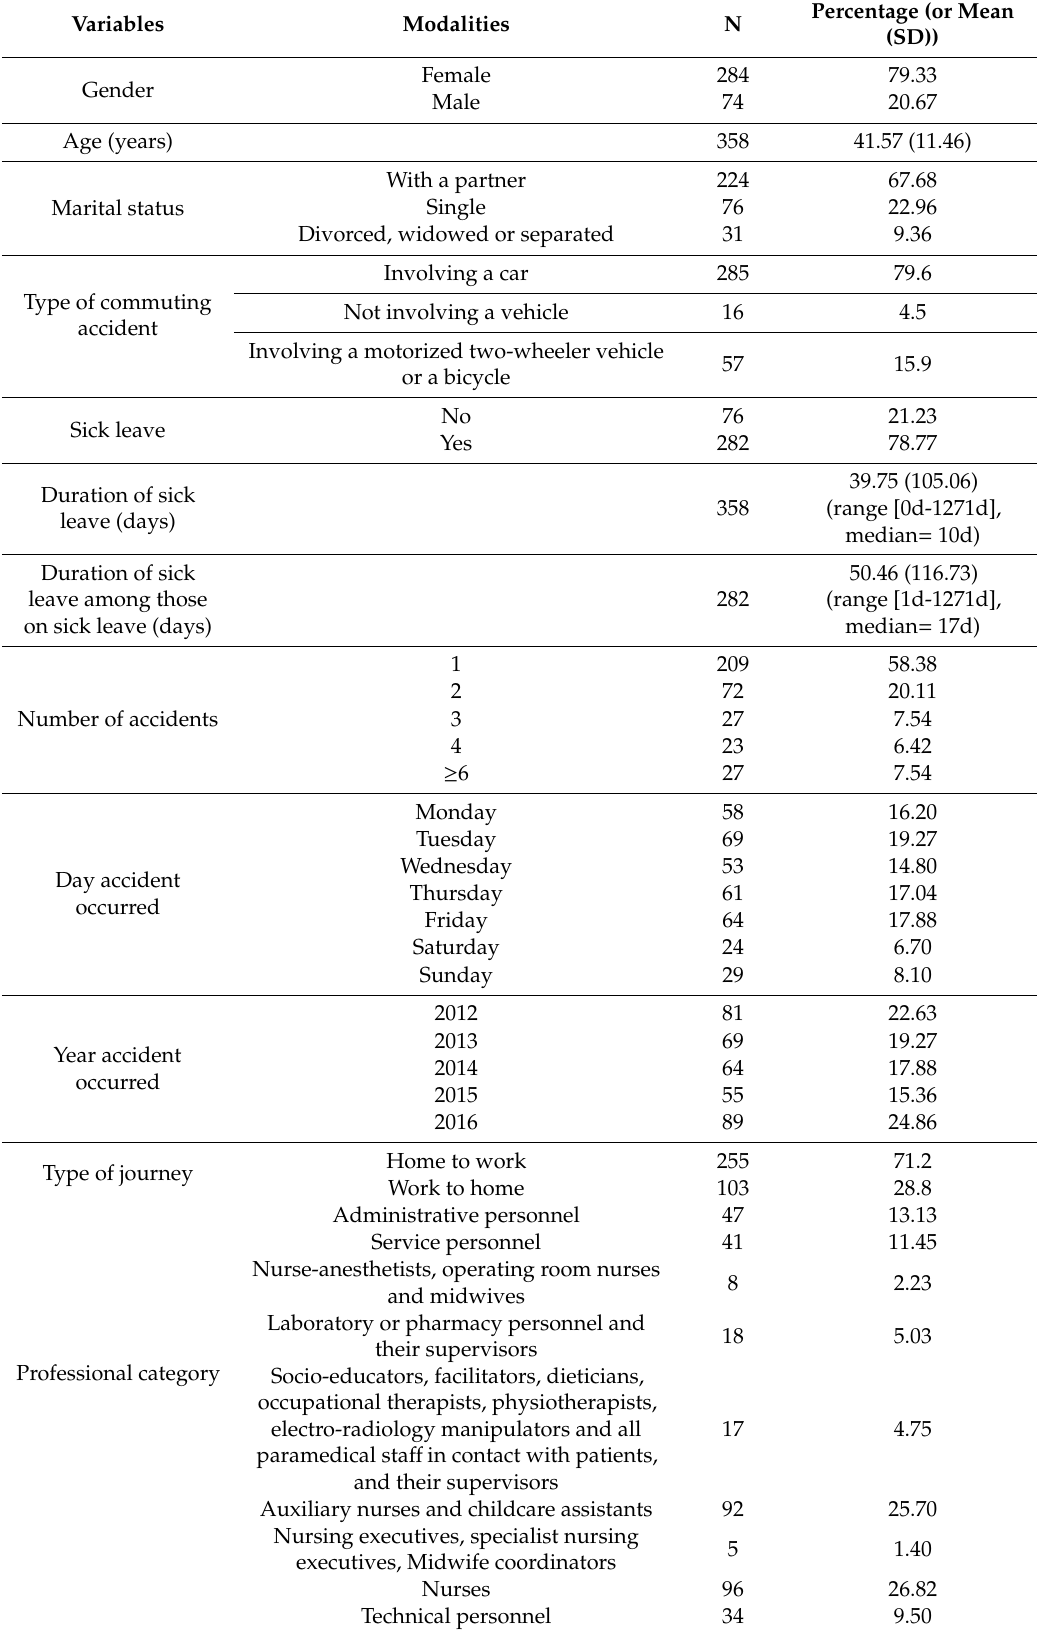
Table 1. Characteristics of cases included in the